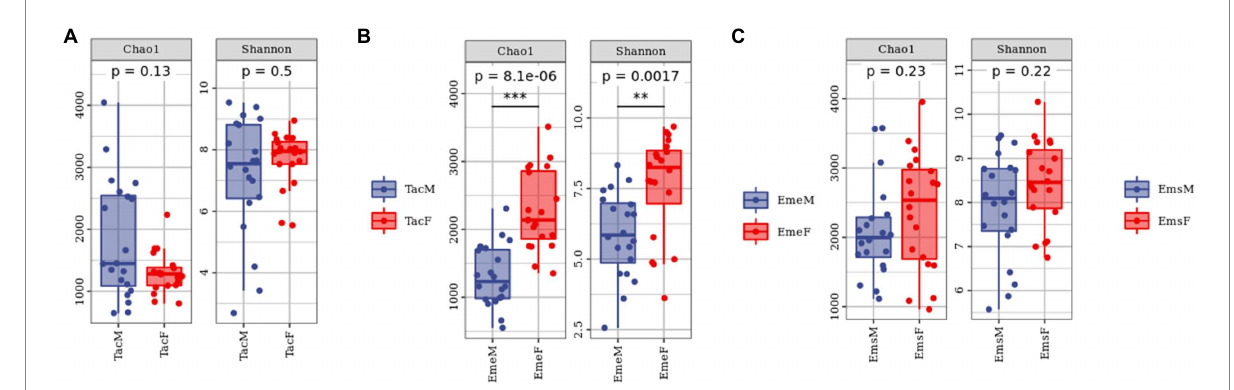
FIGURE 2 Alpha diversity analysis of gut microbiota in migratory birds. Each dot denotes a sample. Each panel corresponds to an alpha diversity index indicated by the gray area at its top. In each panel, the abscissa is the grouping, and the ordinate is the value of the corresponding alpha diversity index. The numbers under the Diversity Index labels are p -values of the Kruskal–Wallis test. Alpha diversity analysis between male and female individuals of (A) Tarsiger cyanurus , (B) Emberiza elegans, and (C) Emberiza spodocephala . The abbreviations in this figure are expanded in the legend of Figure 1. The numbers under the Diversity Index labels are p -values of the Kruskal -Wallis test. **significant difference, ***extremely significant difference.